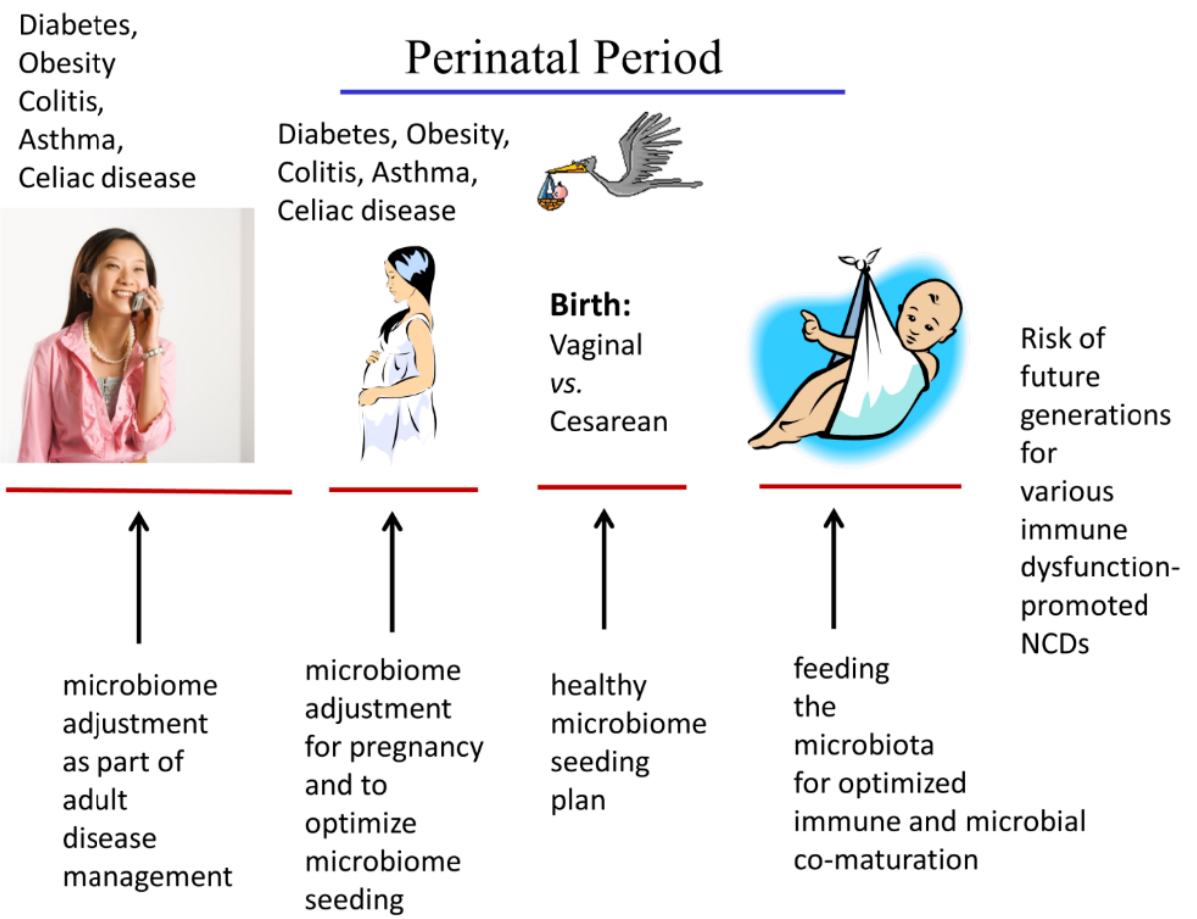
Figure 2. Life stage-based approaches to microbiome management are depicted beginning with the young adult and following through pregnancy and birth + nurturing of the next generation. Considerations for each life stage are illustrated such as the preparation, seeding and feeding of the infant microbome. The perinatal period of development is a particularly important window for potential modifications that could positively impact immune maturation and the risk of immune-related and inflammatory-driven